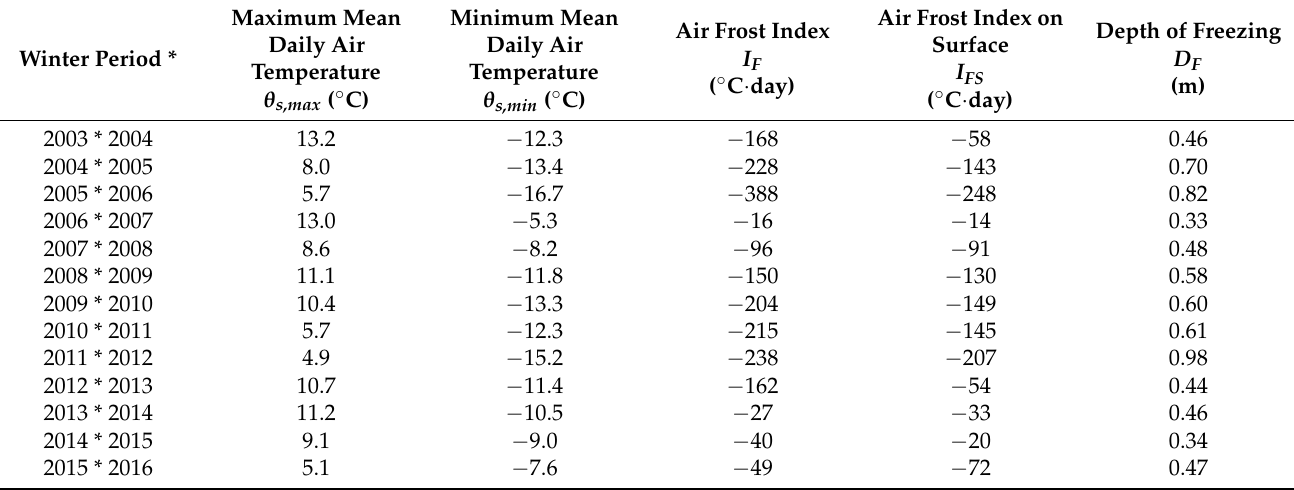
Table 2. Overview of monitored climatic characteristics at the experimental stand No. 1 **.